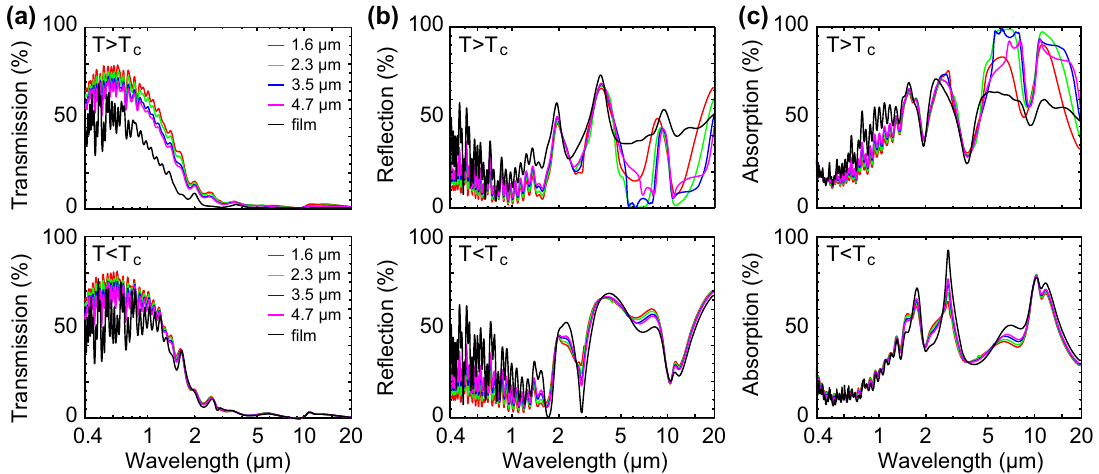
Figure 2: Numerical simulations of optical spectra of VO 2 metasurface thermal emitters with different VO 2 feature size L and gap d = 2 µm. (a – c)Transmission,reflectionandabsorptioninthehotstate( T > T C )andcoldstate( T < T C ).Simulationsforunpatternedthin fi lmareshownfor